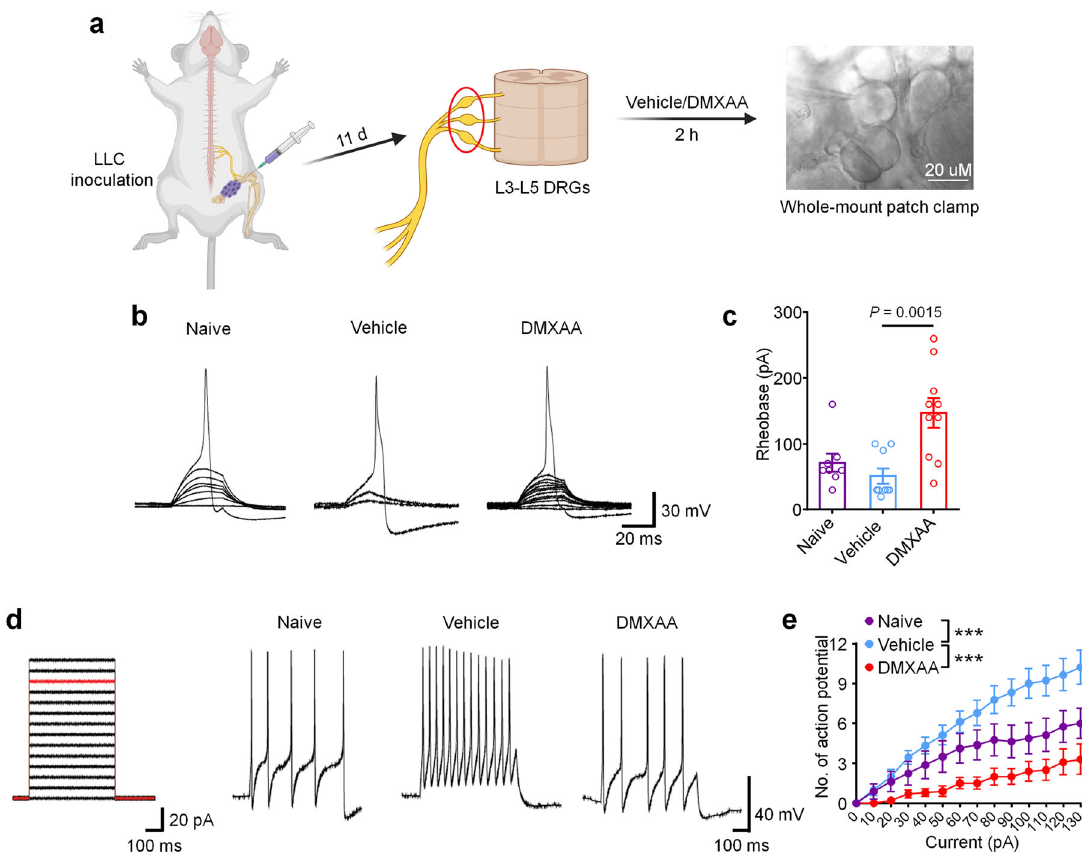
Fig. 4 Ex vivo STING activation inhibits neuronal hyperexcitability of DRGs from cancer-bearing mice. a Schematic of whole-mount DRG preparation, drug treatment, and bright fi eld image with a recording micropipette sealed on a small-diameter neuron (nociceptor). b Representative traces of rheobases: current clamp recordings of the membrane potential from small diameter DRG neurons of naïve mice or bone cancer-bearing animals with or without DMXAA (30 µ M, 2 h). Current injection for action potential induction starts from 0 pA and increases 10 pA per step for 30 ms. c The averages of rheobases from naïve mice, vehicle or DMXAA-treated group (naïve: n = 8 neurons/4 mice; vehicle: n = 9 neurons/4 mice; DMXAA: n = 10 neurons/4 mice). d Left: injected current steps for the induction of action potentials starts from 0 pA and increases 10 pA per step for 300 ms. Right: representative traces showing the response to a 110 pA current injection (red line in left) from small diameter DRG neurons of naïve mice or bone cancer mice with or without DMXAA treatment. e Action potentials in response to increasing current amplitude from naïve mice or bone cancer mice with or without DMXAA (naïve: n = 8 neurons/4 mice; vehicle: n = 9 neurons/4 mice; DMXAA: n = 10 neurons/4 mice), *** P < 0.001. All data indicate the mean ± SEM, one-way ANOVA with Bonferroni ’ s post hoc test ( c ); repeated-measures one-way ANOVA with Bonferroni ’ s post-hoc test ( e ). Source data are provided as a Source Data fi